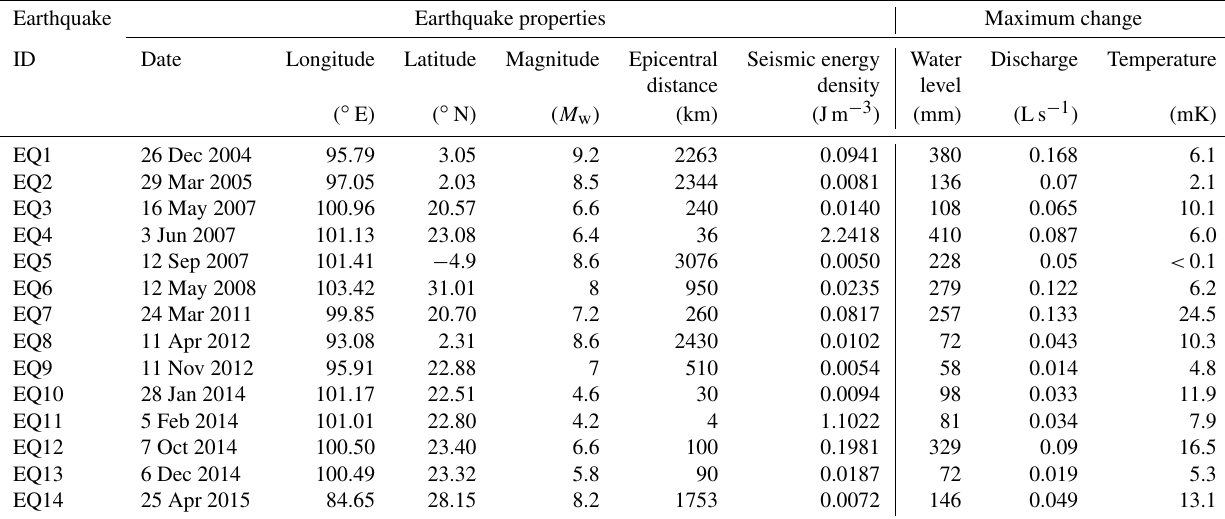
Table 1. Seismic properties for 14 earthquakes and their effects on water levels and temperatures in the Dazhai well, western Yunnan Province, China.